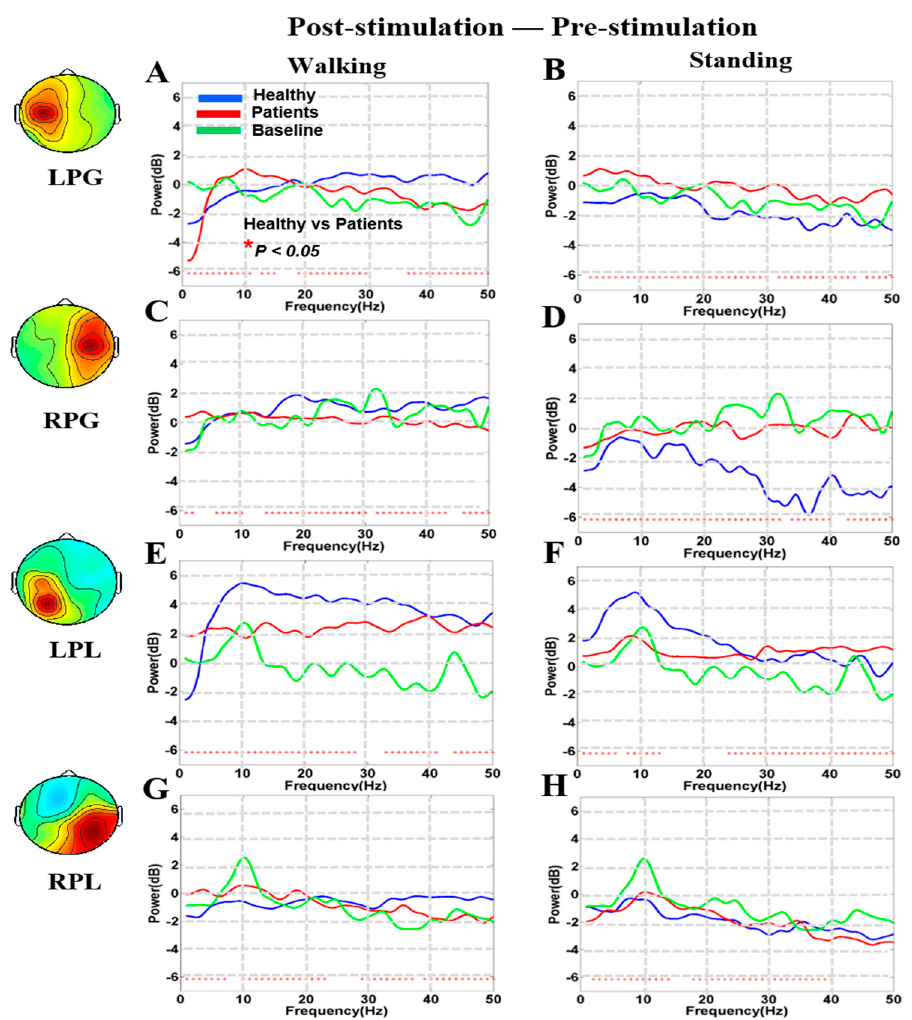
Figure 5. The power spectral density results of the brain with healthy and BVH patients. These result in LPG, RPG, LPL, and RPL shows the effect of noisy GVS (post-stimulation–pre-stimulation) in healthy vs. patients during walking and standing conditions. The power spectra of patients are indicated by red traces and those of healthy subjects are indicated by blue traces. The baseline power spectra are presented by green traces (Figure 5 A – H ). An asterisk shows the significant difference between healthy subject’s vs patients (Wilcoxon signed-rank test, p < 0.05).